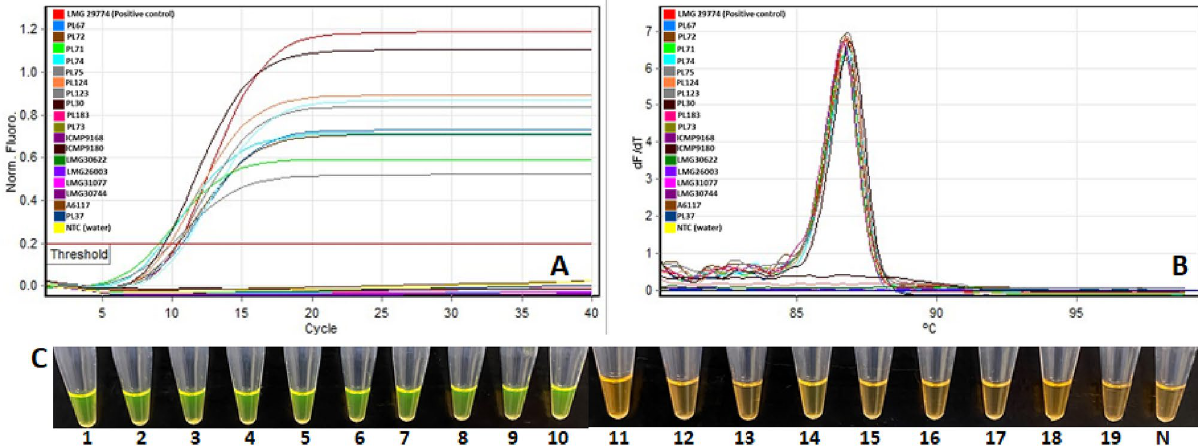
Figure 2. Specificity assay of loop-mediated isothermal amplification (LAMP) for specific detection of Pectobacterium parmentieri . Ten representative strains of P. parmentieri and 10 representative strains from the exclusivity panels are shown. ( A ) Real-time amplification plot with strains from both inclusivity and exclusivity panels; ( B ) melt-curve of 10 strains of P. parmentieri , no melt curve was observed with the strains from exclusivity panel and negative controls; ( C ) visualization of LAMP products after adding 3 μL of SYBR Green I stain. Tube 1, positive control P. parmentieri (LMG29774), tubes 2–10 P. parmentieri (PL67, PL72, PL71, PL74, PL75, PL124, PL123, PL30, and PL183), tubes 11–19 P. carotovorum (PL 73), P. versatile (ICMP 9168), P. polaris (ICMP 9180), P. punjabense (LMG 30,622), P. actinidae (LMG 26,003), P. polonicum (LMG31077), P. fontis